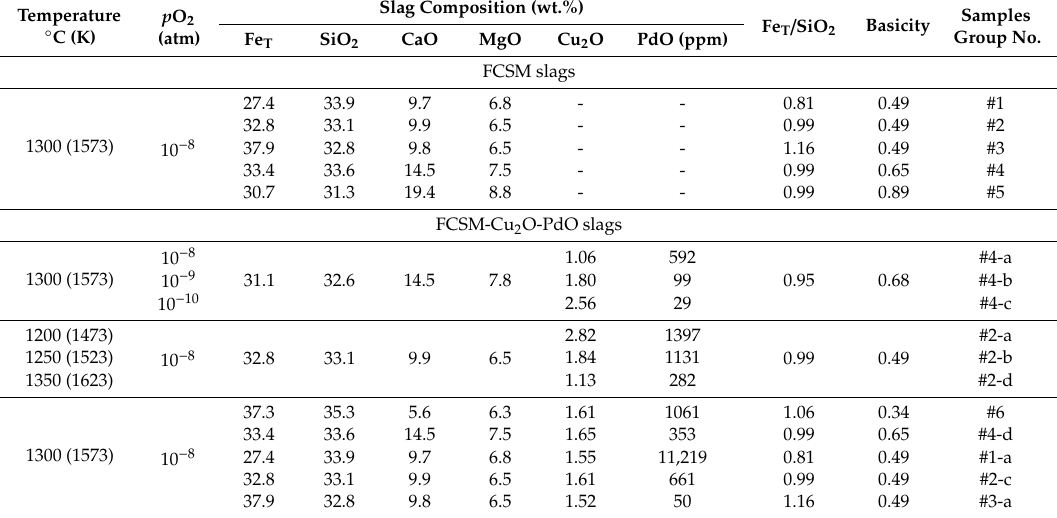
Table 1. Experimental conditions and the equilibrium compositions of the FCSM and FCSM-Cu 2 O-PdO